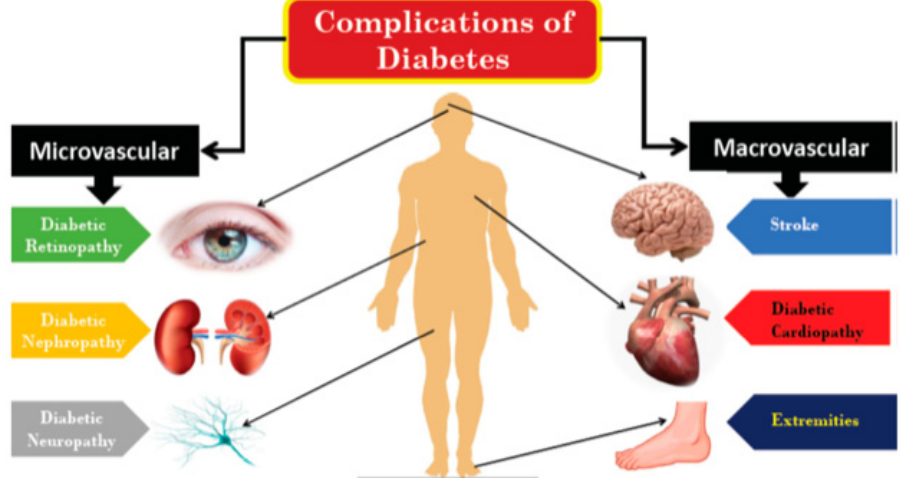
Figure 2. Diabetic microvascular complications have similar etiologies, chronic hyperglycemia initiates diabetic vascular complications through a range of metabolic and structural derangements rooted in the prevalent inflammation, generation of RAGE, ROS production, activation of apoptosis lead to microvascular disease.